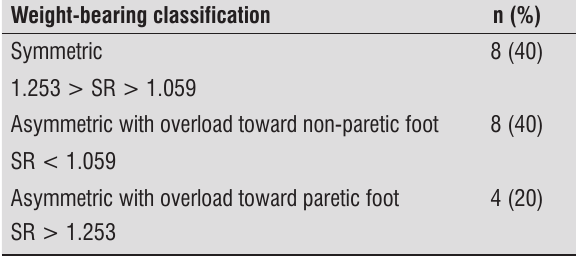
Table 2 - Classification of the subjects with hemiparesis by weight-bearing